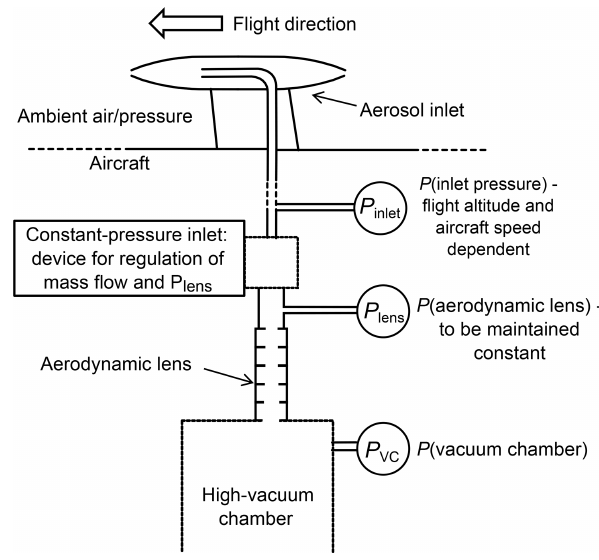
Figure 1. The position of a constant-pressure inlet (CPI) device in the sampling path is indicated in the drawing. The CPI is lo- cated upstream of an aerodynamic lens. Bypass flow or manifolds to other instruments are omitted. The task of the CPI device is to keep the pressure at the aerodynamic lens constant ( P lens ), regard- less of changes in the inlet pressure ( P inlet